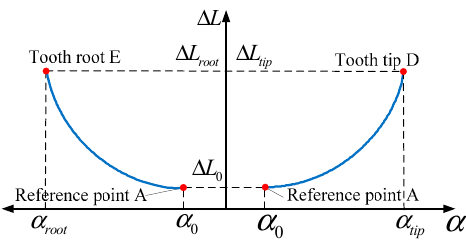
Figure 6. First cycloid relationship between the modification and pressure angle.